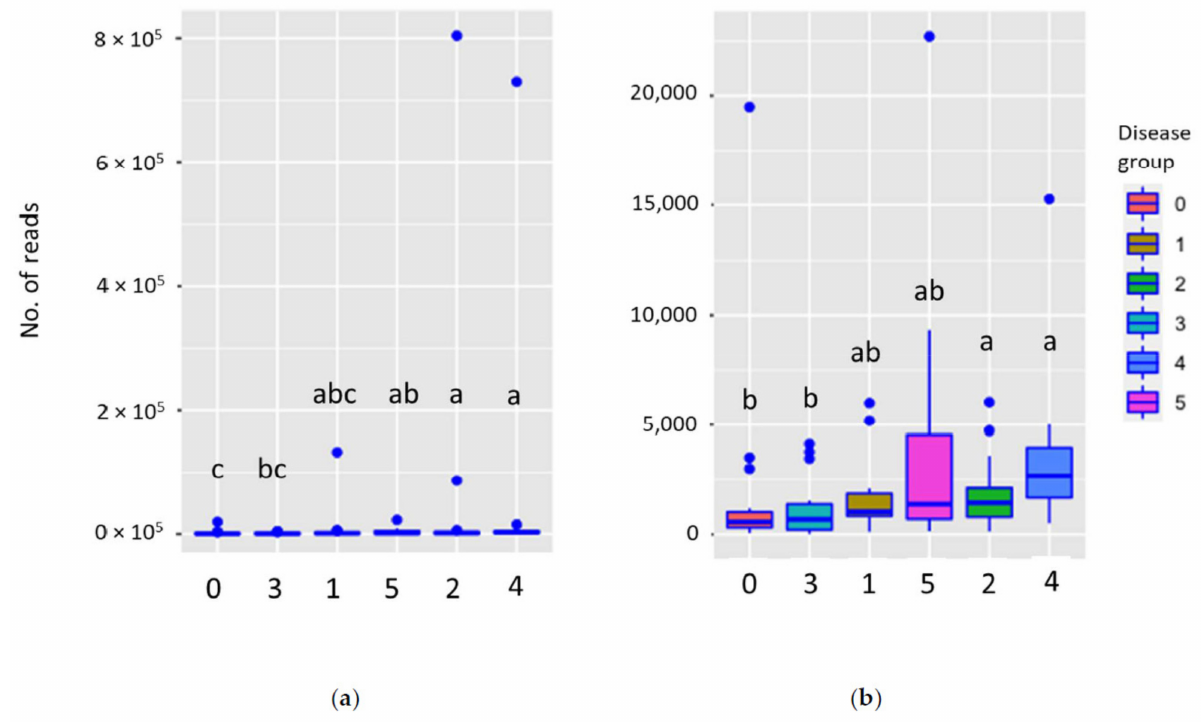
Figure 10. Boxplot of number of Sphaeropsis sapinea HTS reads recorded in disease classes (0–5) with ( a ) and without ( b )